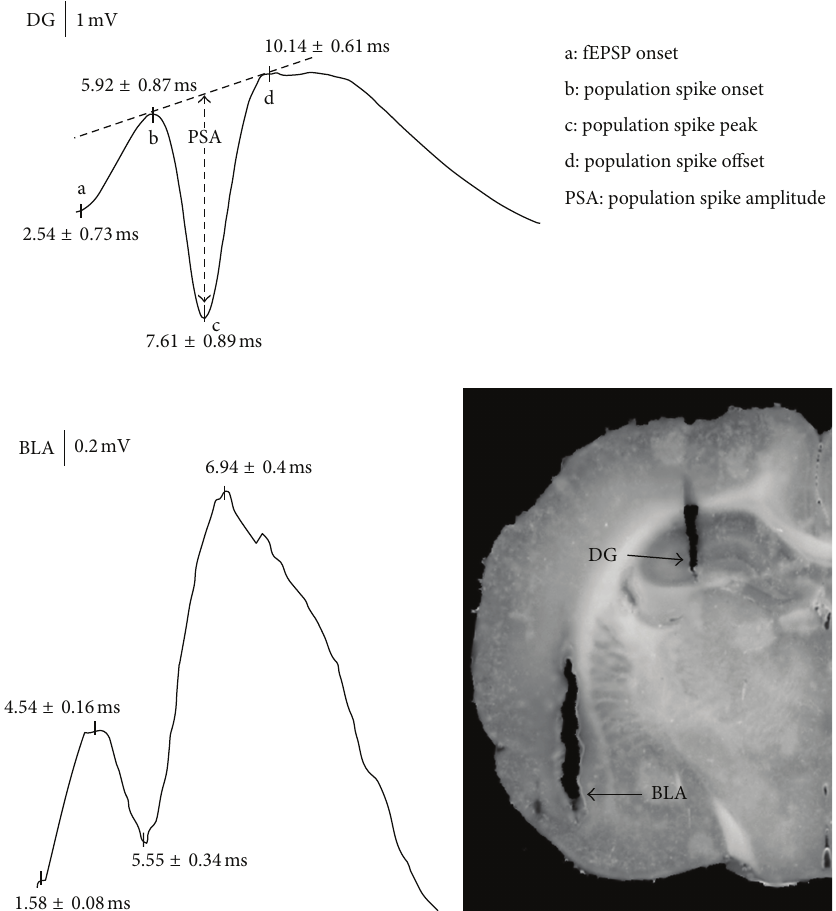
F 1: Representati�e traces of e�oked �eld potentials recorded in BLA and DG in response to stimulation of perforant path �bers. Also shown are methods for �uantifying the amplitude of the population spike (P�A)� as well as histological con�rmation of electrode placement in BLA and